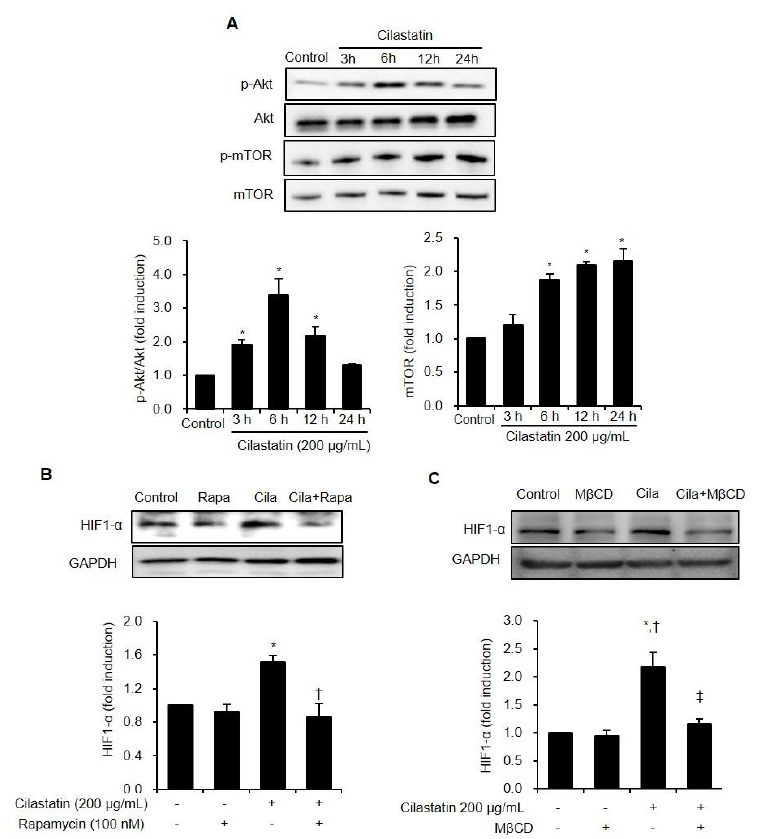
Figure 2. Cilastatin treatment induced HIF-1 α expression via Akt / mTOR dependent pathway in HK-2 cells. ( A ) Semiquantitative immunoblotting revealed increase in Akt and mTOR expression by treatment with 200 µ g / mL cilastatin in a time-dependent manner. The data are presented as means ± SEM. * p < 0.05 vs. control. ( B ) Cilastatin pretreatment increased HIF-1 α expression and the treatment of rapamycin, an mTOR inhibitor, significantly decreased HIF-1 α expression despite cilastatin pretreatment. The data are presented as means ± SEM. * p < 0.05 vs. control, † p < 0.05 vs. rapamycin, and ‡ p < 0.05 vs. cilastatin. ( C ) Cilastatin treatment increased HIF-1 α expression and the destruction of lipid raft by M β CD significantly decreased HIF-1 α expression despite cilastatin treatment. The data are presented as means ± SEM. * p < 0.05 vs. control, † p < 0.05 vs. M β CD, and ‡ p < 0.05 vs. cilastatin.